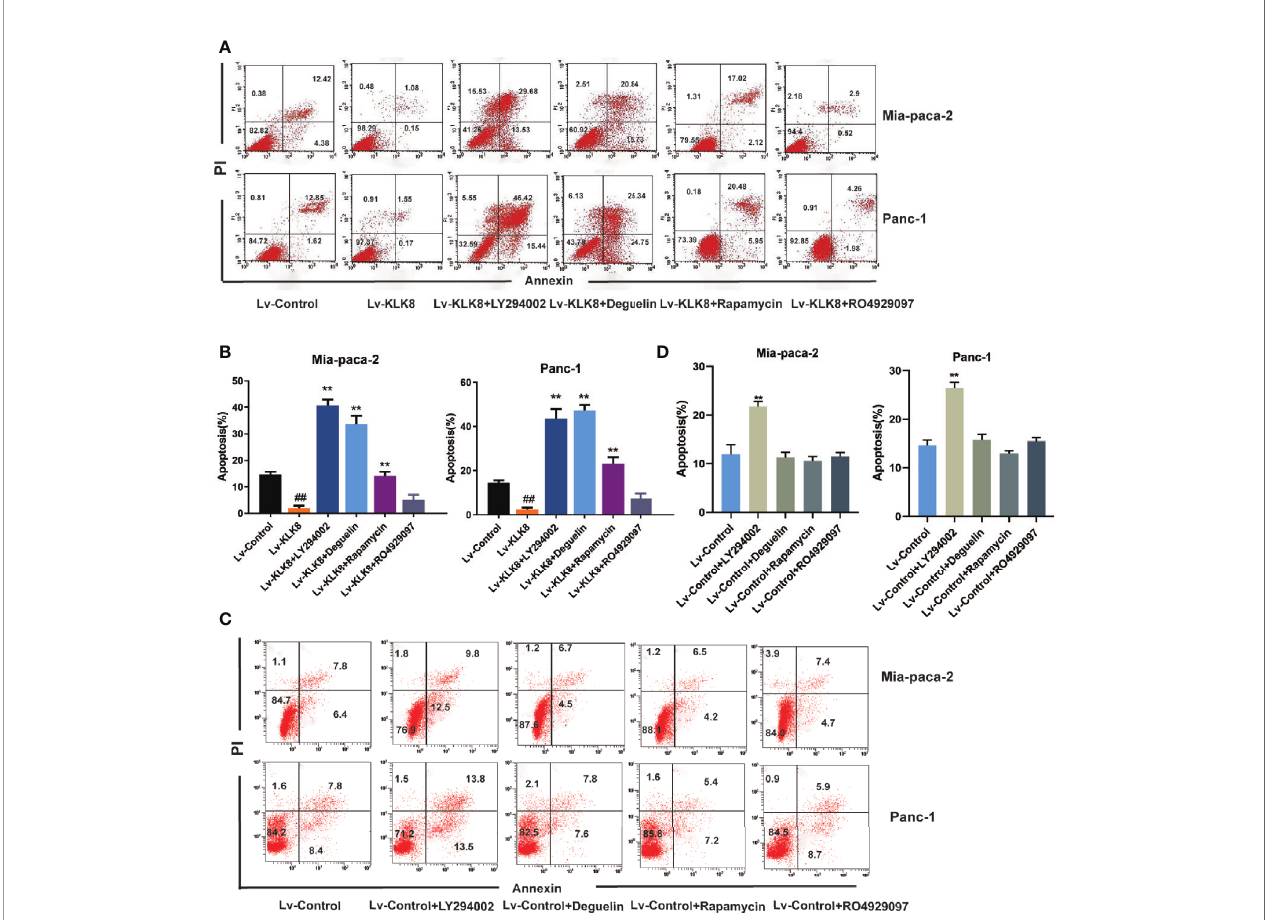
FIGURE 7 | KLK8 suppressed pancreatic cancer cells apoptosis through the activation of PI3K-Akt-mTOR pathway. Mia-paca-2 and Panc-1 cells in Lv-Control and Lv-KLK8 were treated with PI3K inhibitor LY294002 (75 m M), Akt inhibitor Deguelin(500 nM), mTOR inhibitor Rapamycin (100 nM) or Notch inhibitor RO4929097 (10 m M). Cell apoptosis was determined by Annexin V-FITC and PI double staining analysis performed by fl ow cytometry. Representative fl ow cytometry images were shown (A, C) . (B, D) demonstrated the quanti fi ed data of cell apoptosis. Data are presented as means ± SEM (n = 3). **p < 0.01 vs Lv-control; p < 0.05, ## p < 0.01 vs